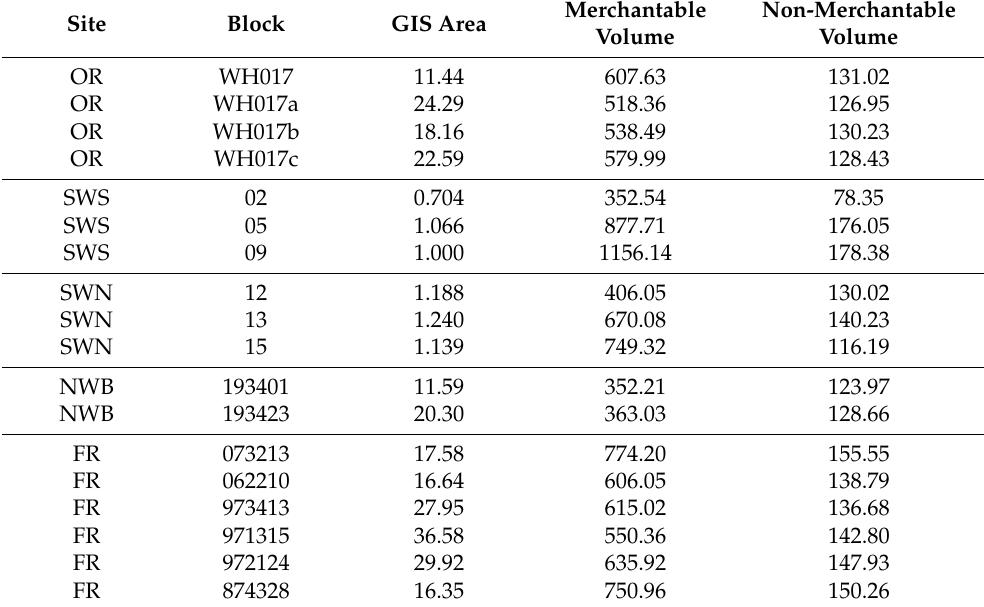
Table 4. Block digitized areas (ha) and block-level HB random forest model estimates of merchantable (m 3 ha − 1 ) and non-merchantable volumes (m 3 ha − 1